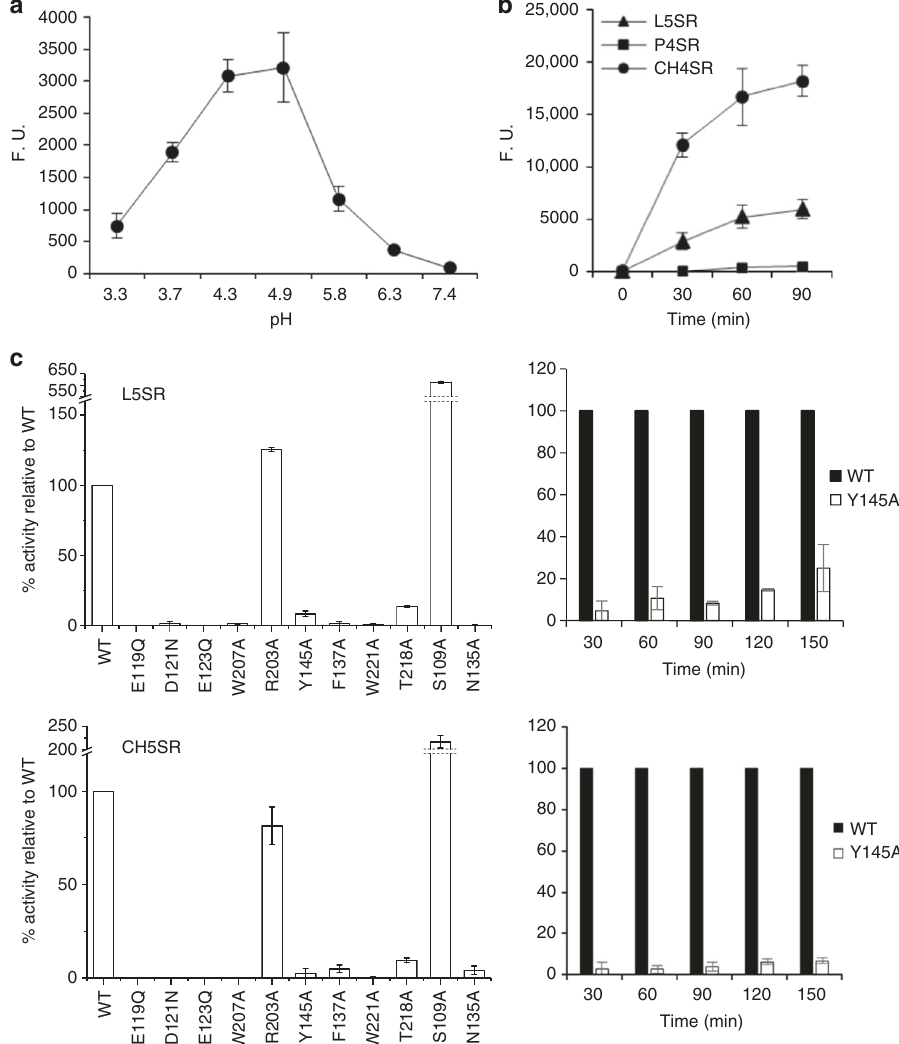
Fig. 2 In vitro transglycosylase activity of Af Crh5 and mutant proteins. a Determination of optimum pH for Af Crh5 transglycosylase activity measured after 60min of reaction using 18 µ M SR-labelled laminaripentaose (L5-SR) as acceptor and CM – chitin (0.1%) as donor in de fi ned 50mM citrate buffer. F.U. represents arbitrary fl uorescence units determined for each time point after substracting the value at the time of adding the enzyme (time 0). b Comparison of transglycosylation rates catalysed by Af Crh5 using equimolar concentrations of the respective SR-labelled oligosaccharides as acceptors and CM – chitin as a donor. The reactions were carried out under standard conditions described in Methods at the indicated times using 4.9 as optimum pH. c Transglycosylase activity of Af Crh5 mutant proteins relative to the WT activity (100%) using L5-SR or CH5-SR as acceptors was measured as in b after 90min of reaction. For the Y145A mutant a time course enzymatic activity experiment including longer incubation time is also included. Data represent the average and standard deviation of at least three independent experiments. Source data are provided as a Source Data fi